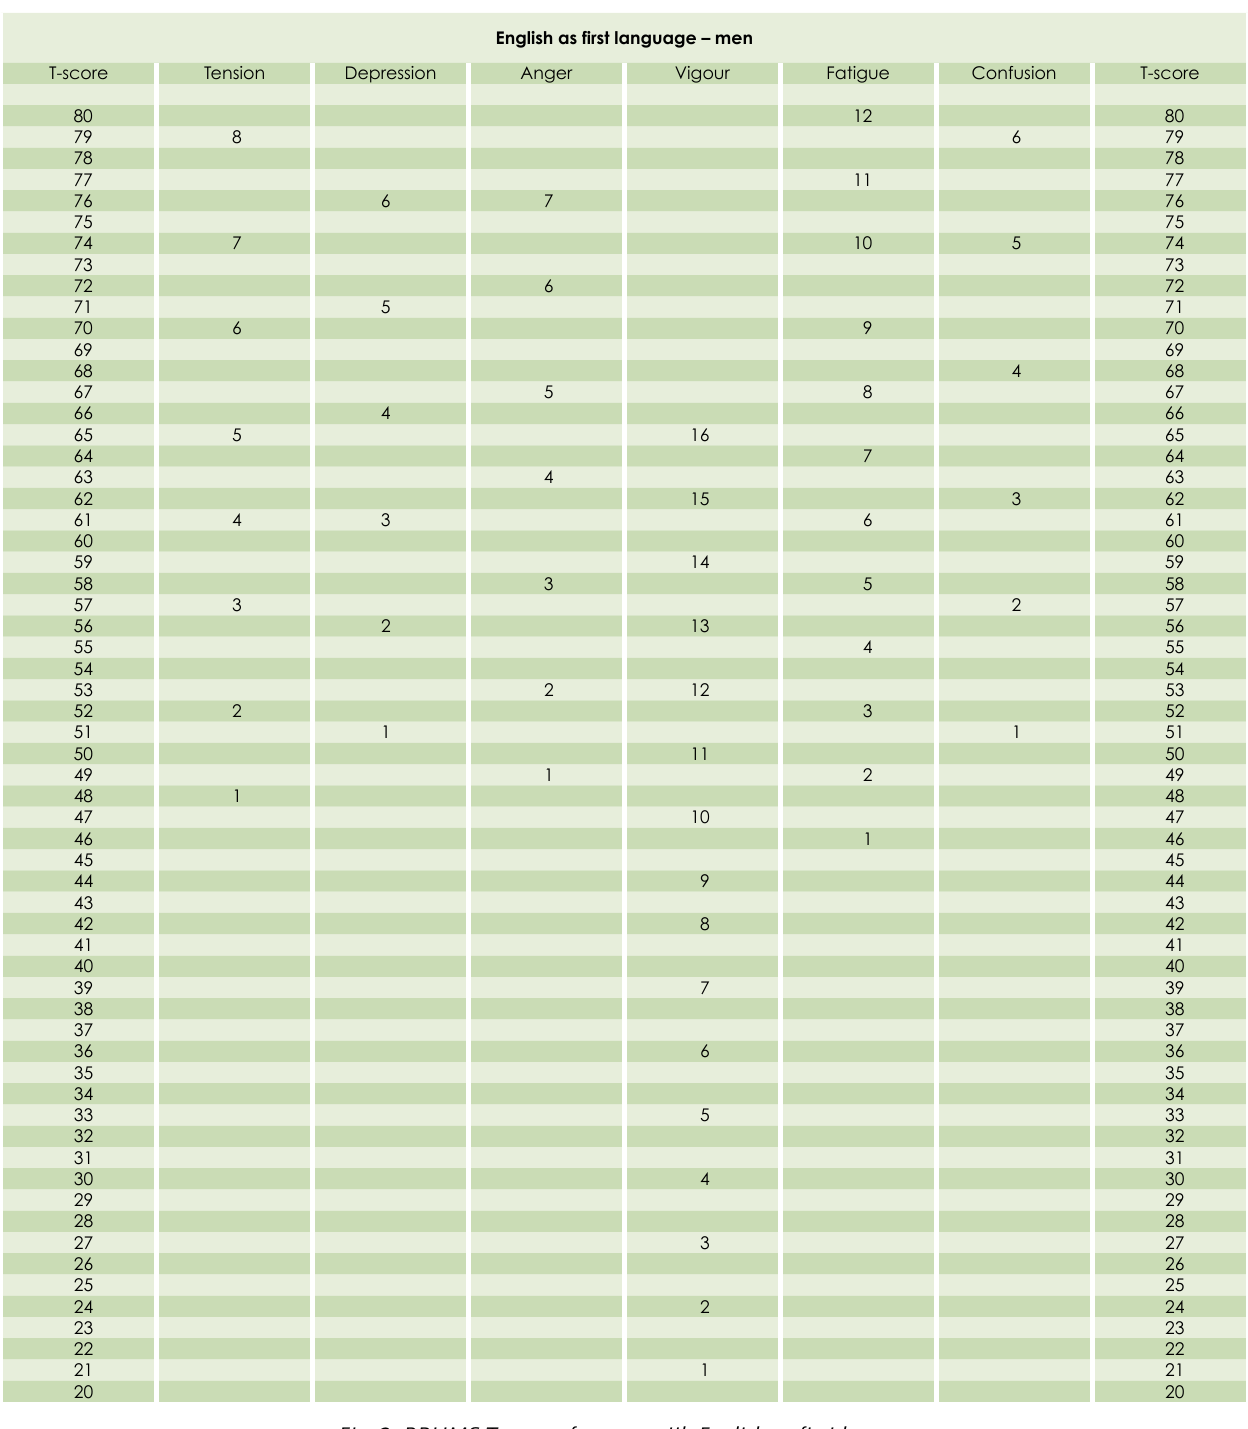
Fig. 2. BRUMS T-scores for men with English as first